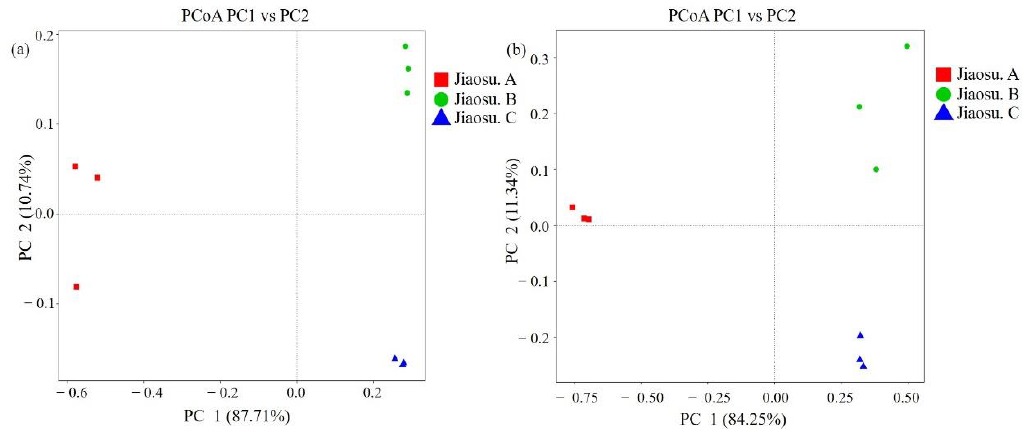
Figure 3. Principal coordinate analysis (PCoA) of the bacterial ( a ) and fungal ( b ) communities in all samples. Note: PC1 and PC2 were used to plot all PCoA results.